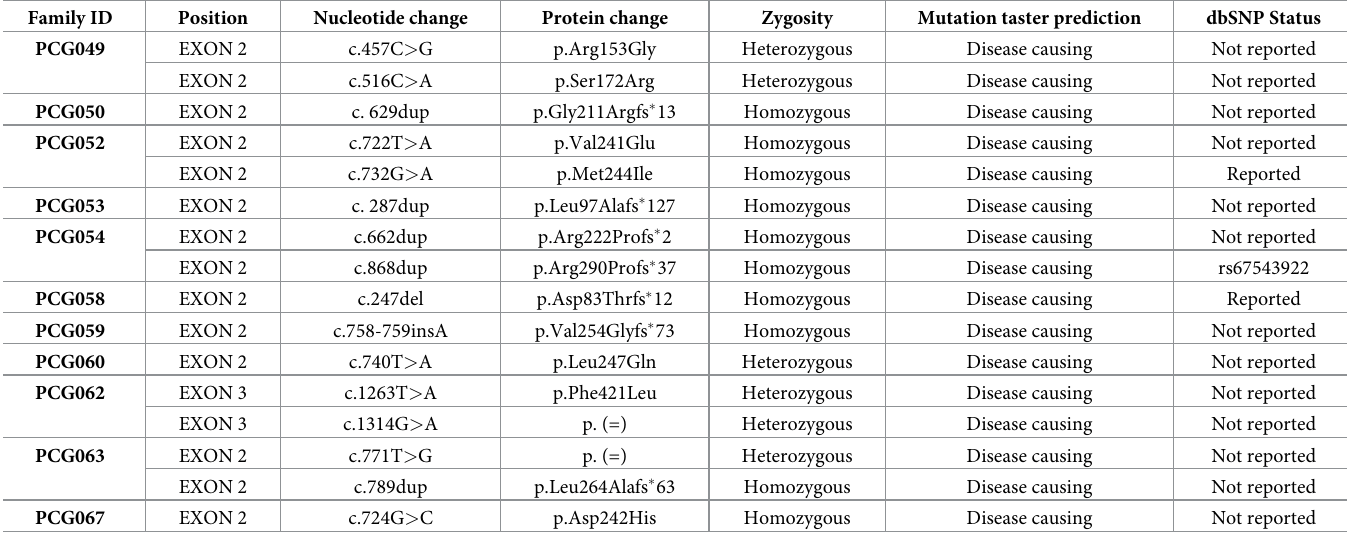
Table 1. List of reported and novel disease-causing variants detected in this study upon sequencing of CYP1B1 gene in PCG patients. Family